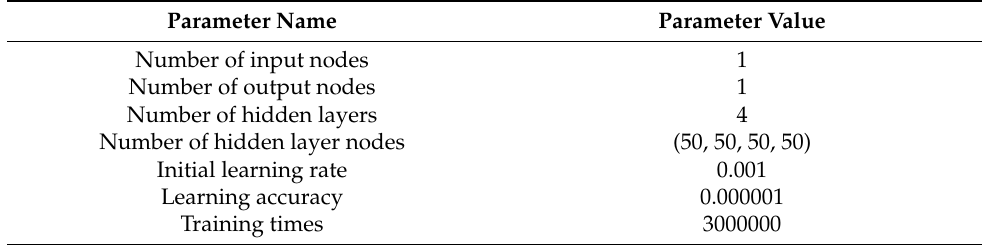
Table 1. Parameters of BP neural